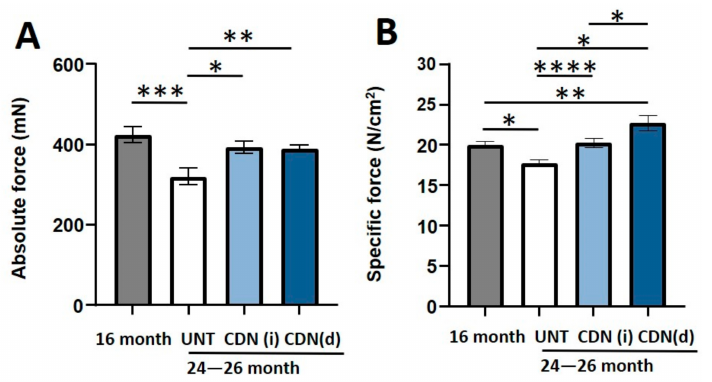
Figure 3. Force generating capacity. CDN1163 prevented the age-related reduction in the absolute ( A ) and specific force ( B ) of extensor digitorum longus (EDL) muscles in the 26 months old, aged mice when compared to vehicle treated control group. Values are expressed as mean ± SEM; ( n = 8–9 mice/group); one-way analysis of variance. * p ≤ 0.05, ** p ≤ 0.01, *** p ≤ 0.001, **** p ≤ 0.0001.